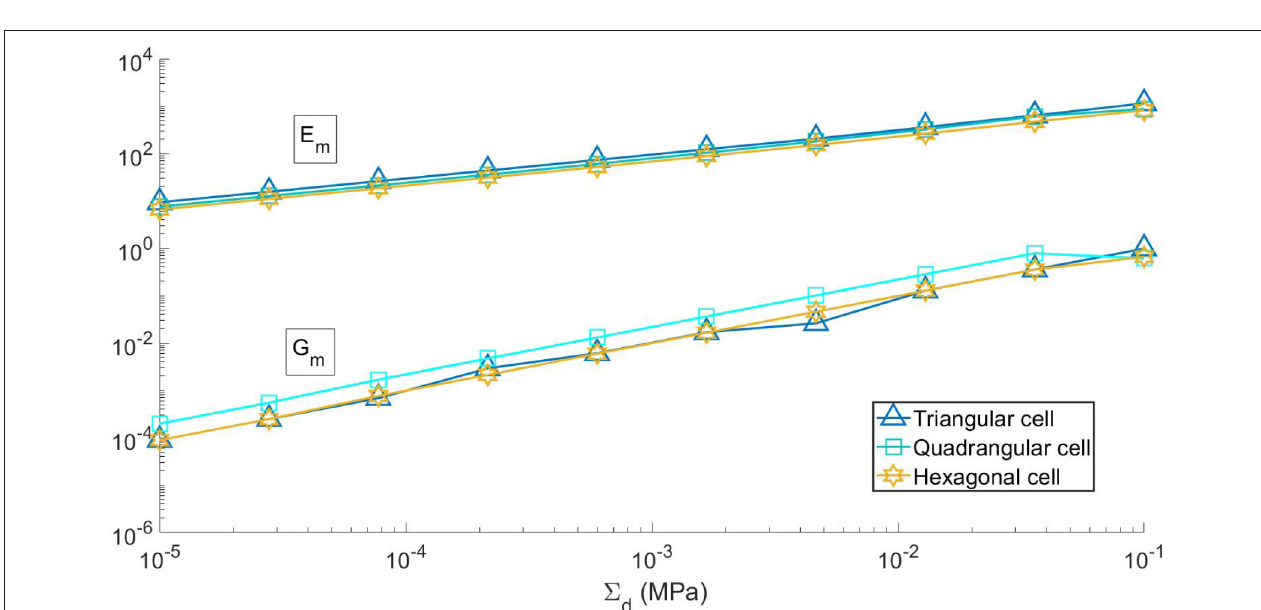
FIGURE 4 | Optimal volume density.